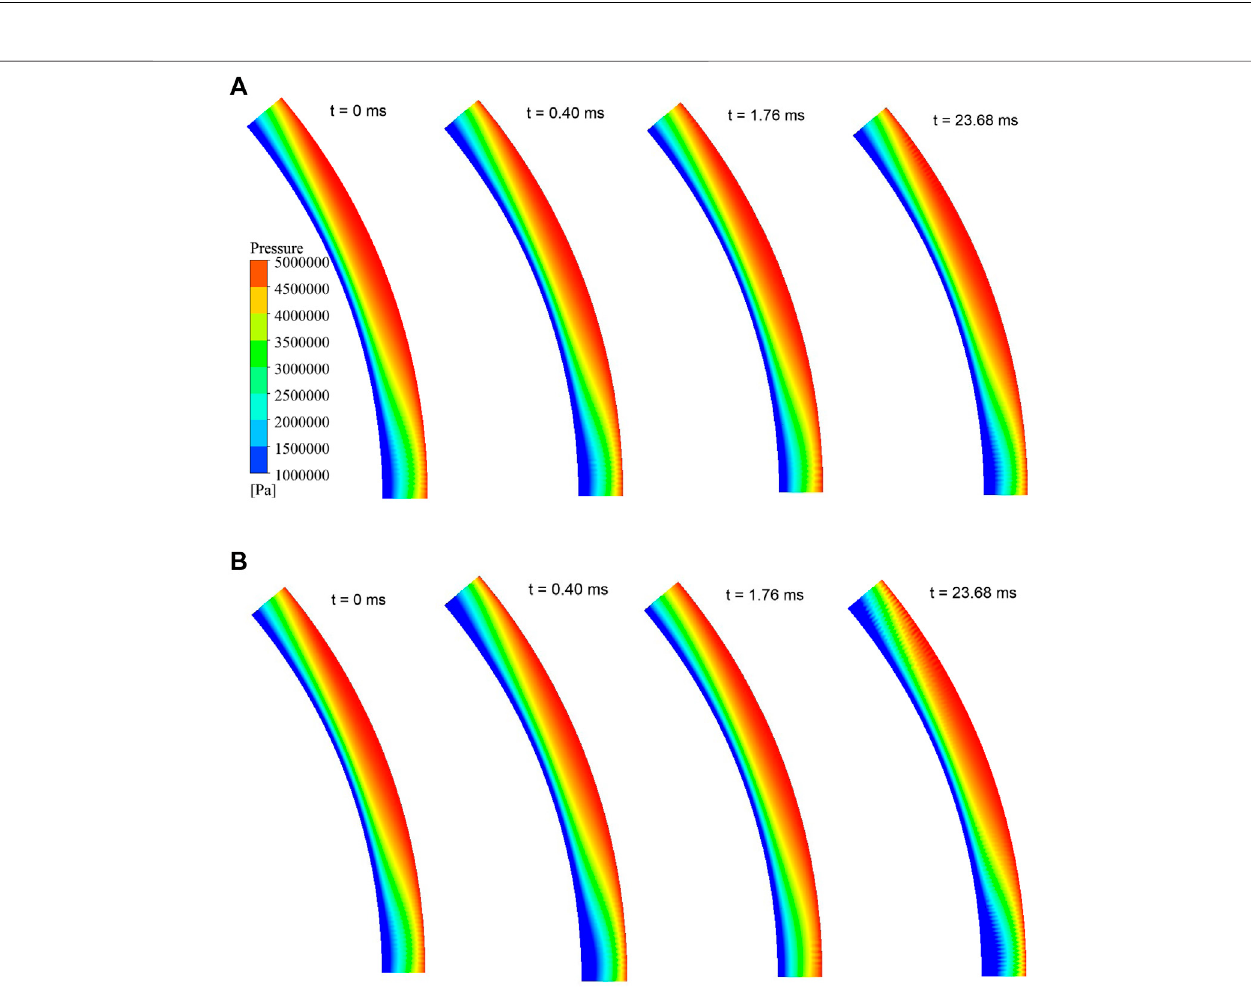
FIGURE 12 | Pressure distribution varies with time (A) a = 4% and (B) a = 10%.